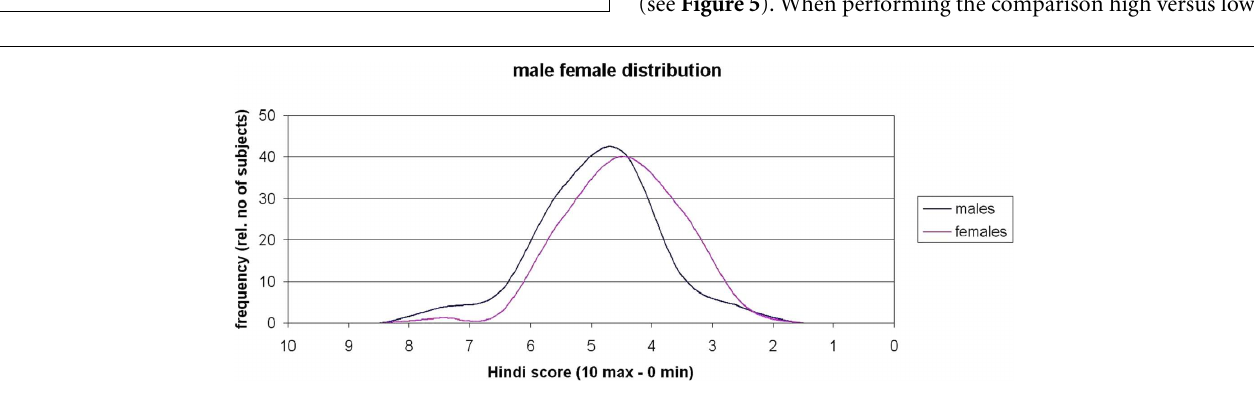
FIGURE 3 | Gender differences: Hindi speech imitation (“Hindi scores,” 1–3) and other score differences [4–6; 4 = non-verbal IQ score; 5 = TOEFL grammar score; 6 = Behavioral Inhibition Score (BIS)] with respect to the male (gray bars)/female (white bars) differences. Scale for Hindi scores (1–3): 0 (min)–10 (max); scales of other scores (4–6) normalized. Mean Hindi score ( y -axis) averaged over (1) 18 Indian native speakers (11 males/7 females) and in (2) + (3) over 138 German natives (53 males/85 females). In the case of the other scores (4–6) mean scores were averaged over N = 113 (German natives). Significant gender differences were obtained for (2), the Hindi score by the Indian native judges (see Figure 2 ): mean score males: 4.92 (SD ± 1.0); females: 4.44 (SD ± 0.89); group difference ( t -test of independent samples): p = 0.005*; and for (6) the BIS score: mean score males: 5.6 (SD ± 1.2); females: 7 (SD ± 0.9); group difference: p = 0.000**. A minor difference at trend level resulted for (3) – the Hindi score as judged by a German expert phonetician. Mean score males: 7.7 (SD ± 0.8); mean score females: 7.3 (SD ± 0.9), group difference: p = 0.028.